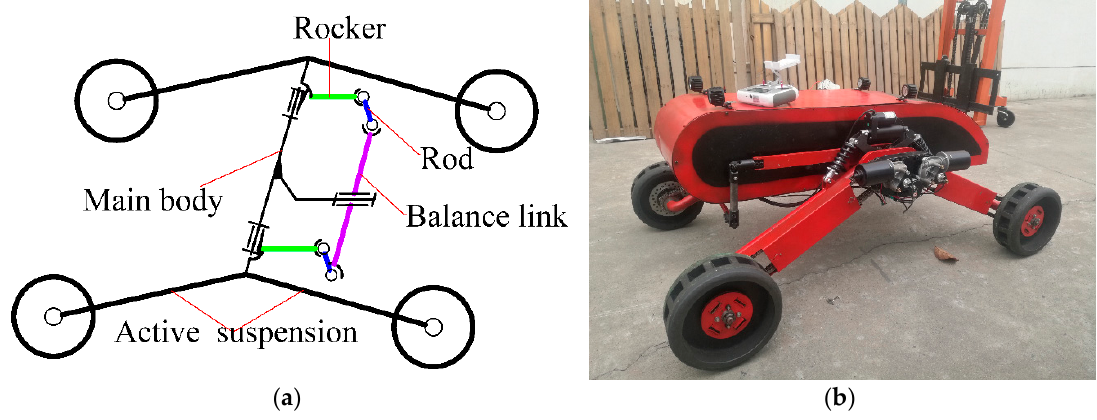
Figure 2. Mobile robot: ( a ) Simple model; ( b ) Practical model.